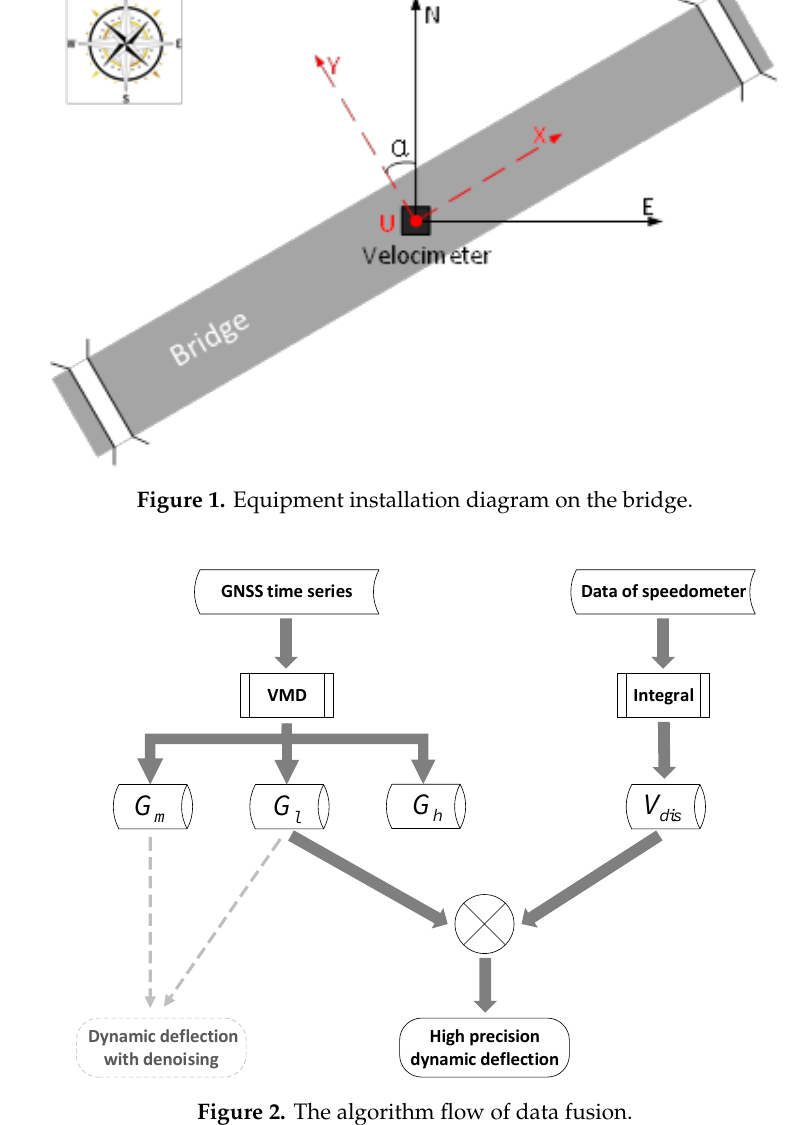
Figure 2. The algorithm flow of data fusion.